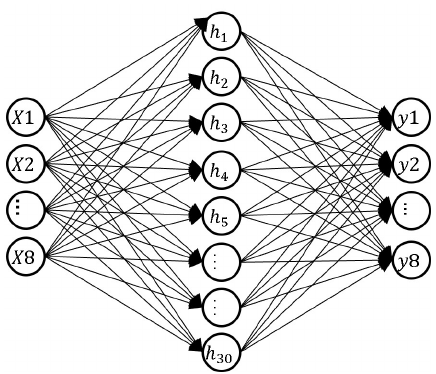
Figure 6. The adopted MLP model architecture. It consists of an input layer with 8 neurons for 8 sensors signals; a hidden layer with 30 neurons, and an output layer with 8 neurons for 8 postures classification.